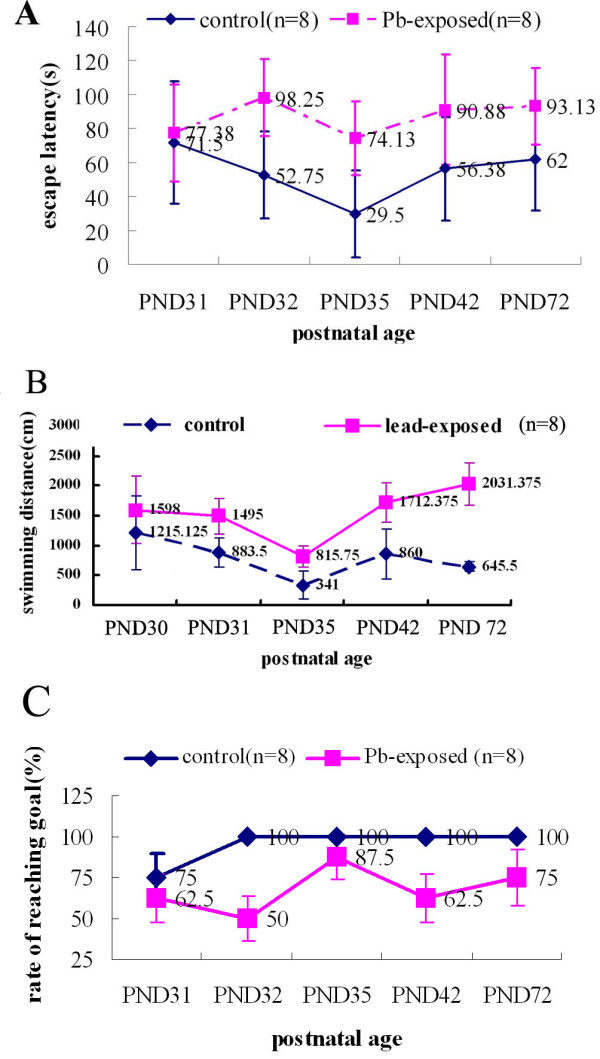
MWM analysis of lead-exposed and control rats over 42 days of MWM acquisition revealed a statistically significant behavioral deficit. (A) Escape latency (mean ± standard deviation) of the two groups. (B) Swimming distance (mean ± standard deviation) of the two groups. Baselines of pretraining latency and distance traveled were not significantly different between the two groups (P = 0.39 and P = 0.22, n = 8). With training proceeding, controls had higher learning efficiency and shorter goal latencies and distance than lead-exposed rats (P = 0.001 and P < 0.001 by repeated-measures analysis of variance, n = 8). (C) Rate (mean ± standard deviation) of reaching goal of the two groups. On PND35, PND 42, and PND 72, all the control rats found the platform within 120 seconds whereas some of lead-exposed rats failed to do so.